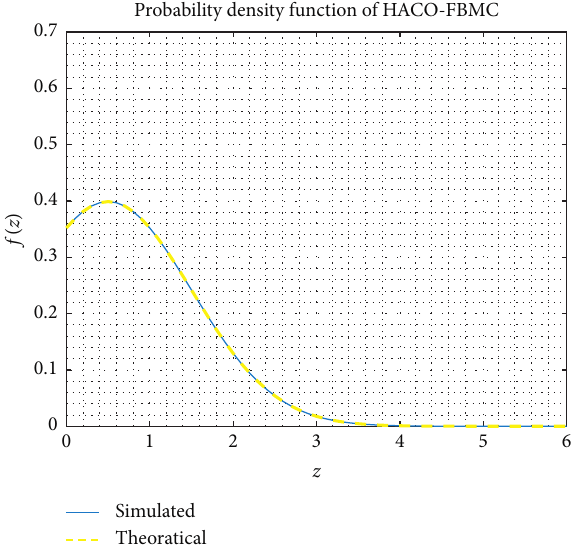
Figure 4: Probability density function of HACO-OQAM-FBMC.